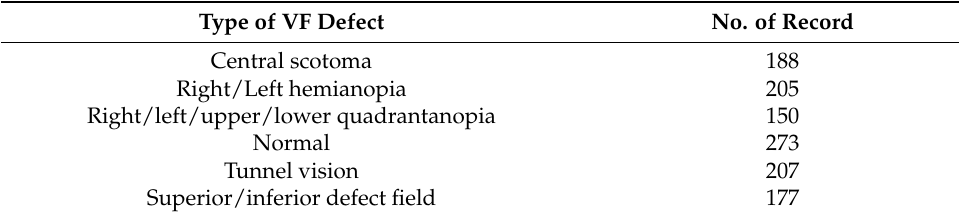
Table 1. Distribution of VF Defects from Collected Datasets. Type of VF Defect